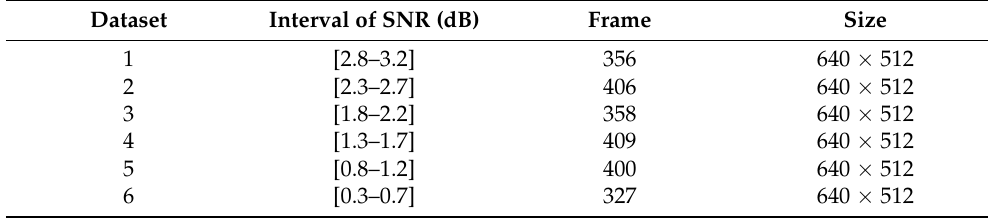
Figure 15. Comparison experiment results diagram: Partial detection results for targets with a SNR of 1 dB. Table 10. Running time of di ff erent methods when the SNR is 1 dB. Table 11. Detail of real